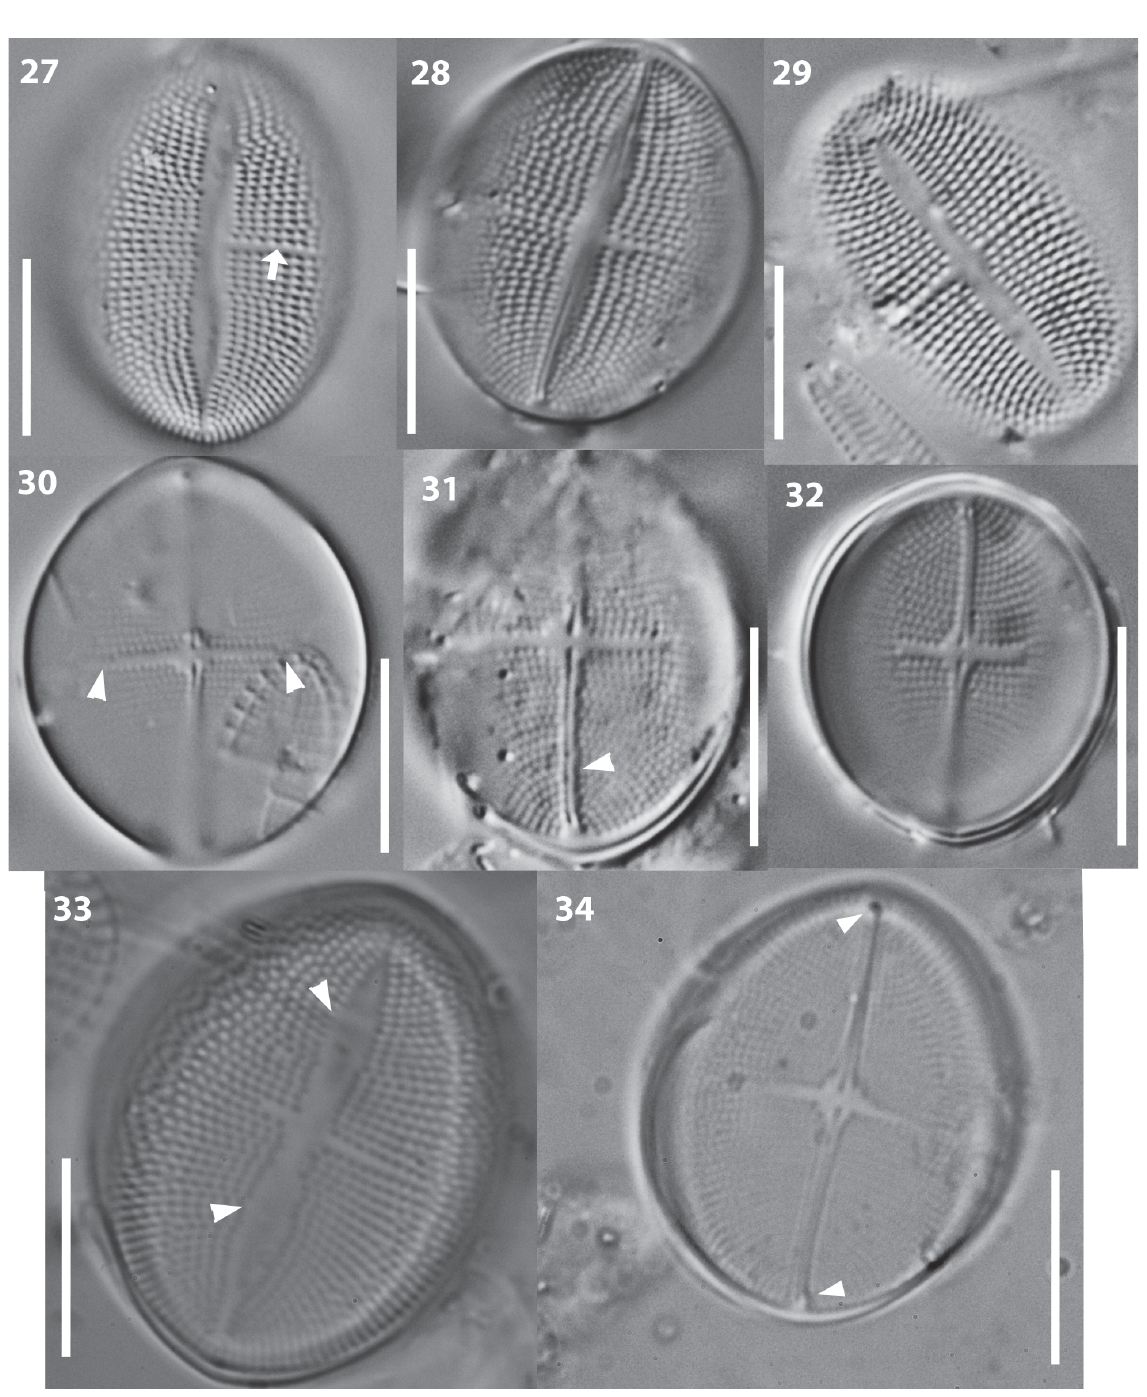
Figs 27–34. Cocconeis diaphana W.Sm. “Sidmouth” (var. β). 27–32 . From VI-45-B10 (H.F. Van Heurck collection). One SV stria lacking on one side, or both sides (27, arrow, 28–29), RV fascia narrow and extended (30, arrowheads), raphe slightly sigmoid (31, arrowhead), proximal raphe endings robust (30–32). 33–34 . From BM 19589, SV sternum in two lanceolate parts (33, arrowhead), helictoglossae deflected in opposite directions (34, arrowheads). Scale bars = 10